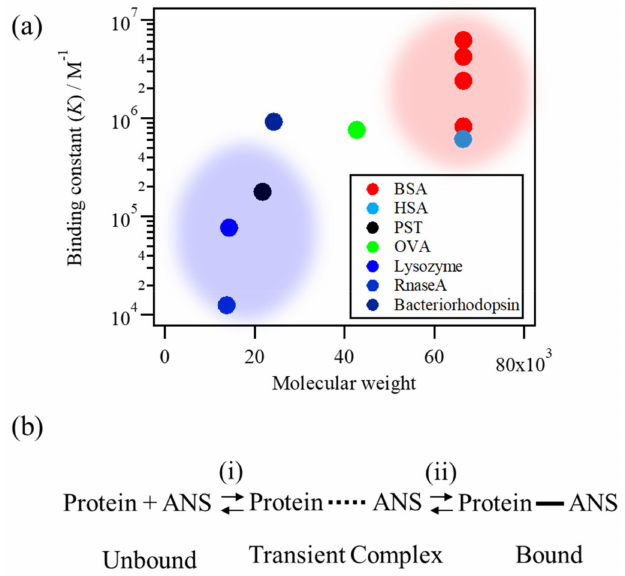
Figure 2. ( a ) The ANS–protein binding constants ( K ) of various proteins [9–13]. ( b ) An assumption about the ANS–protein binding